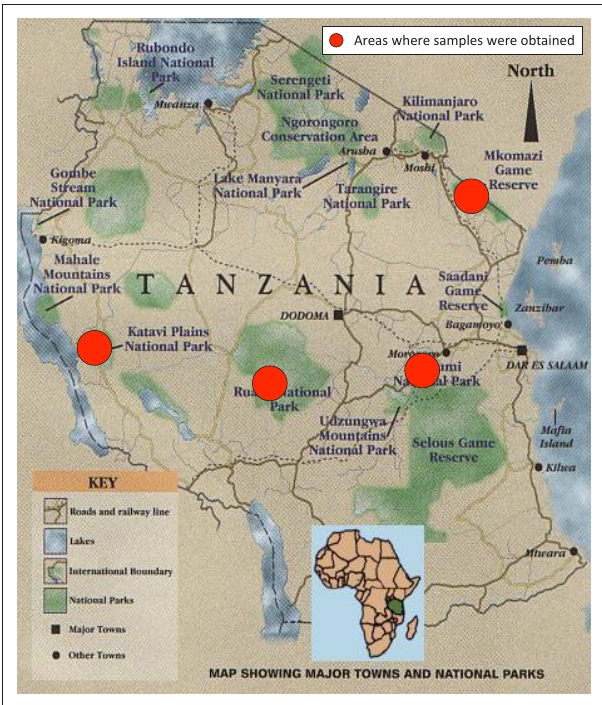
FIGURE 1: Map of Tanzania showing sampling areas.